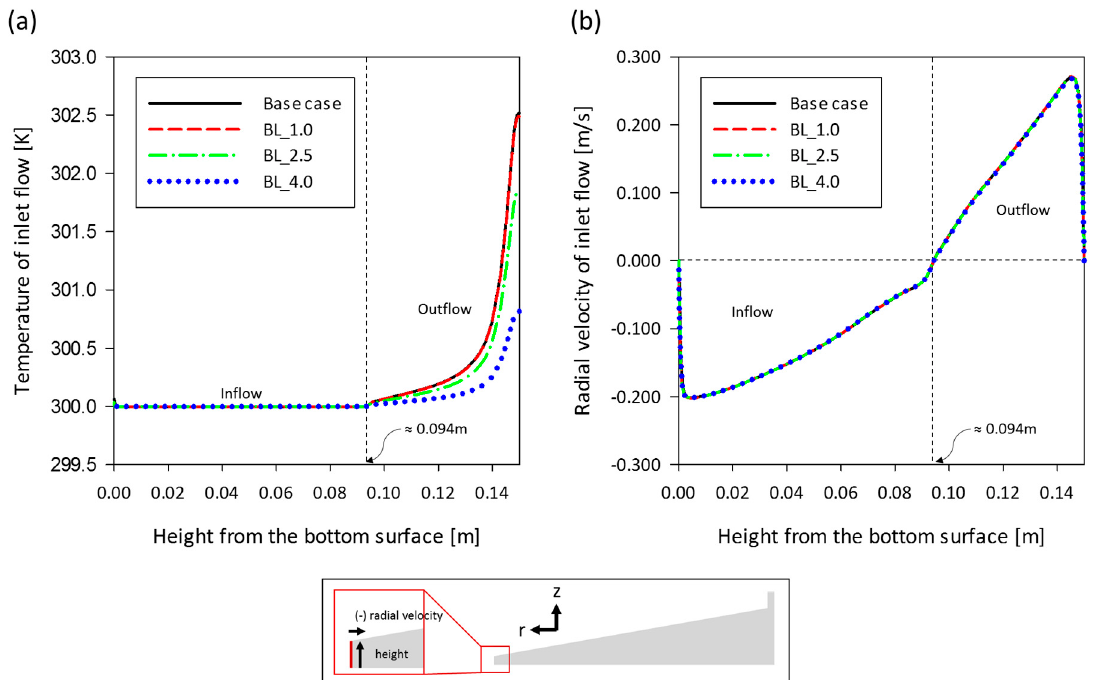
Figure 5. The effect of the baffle blocking the outside air: The temperature and the velocity profiles are measured at the red line marked in the inset below. ( a ) The temperature profiles at the inlet show significant changes in the outward flows depending on the installation location of the baffle; however, ( b ) the radial velocity profiles at the inlet are not different meaningfully. Above the height of 0.094 m, the radial directional flow has a positive value, which indicates that the flow is directed to the outside. This flow reduces the efficiency by discharging the heat inside the collector to the outside.